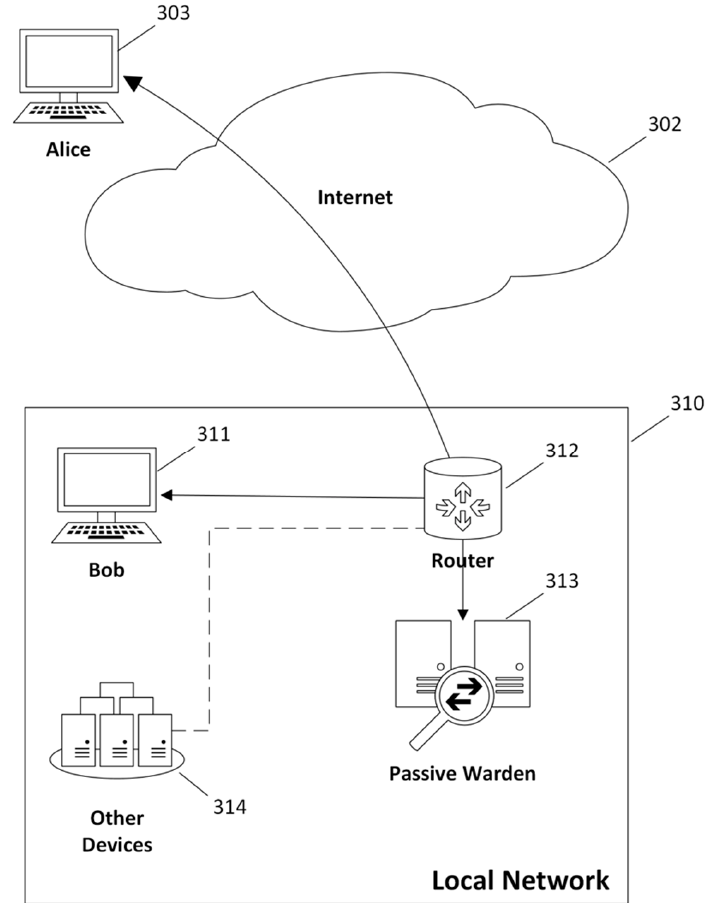
Figure 6. Implementation architecture .